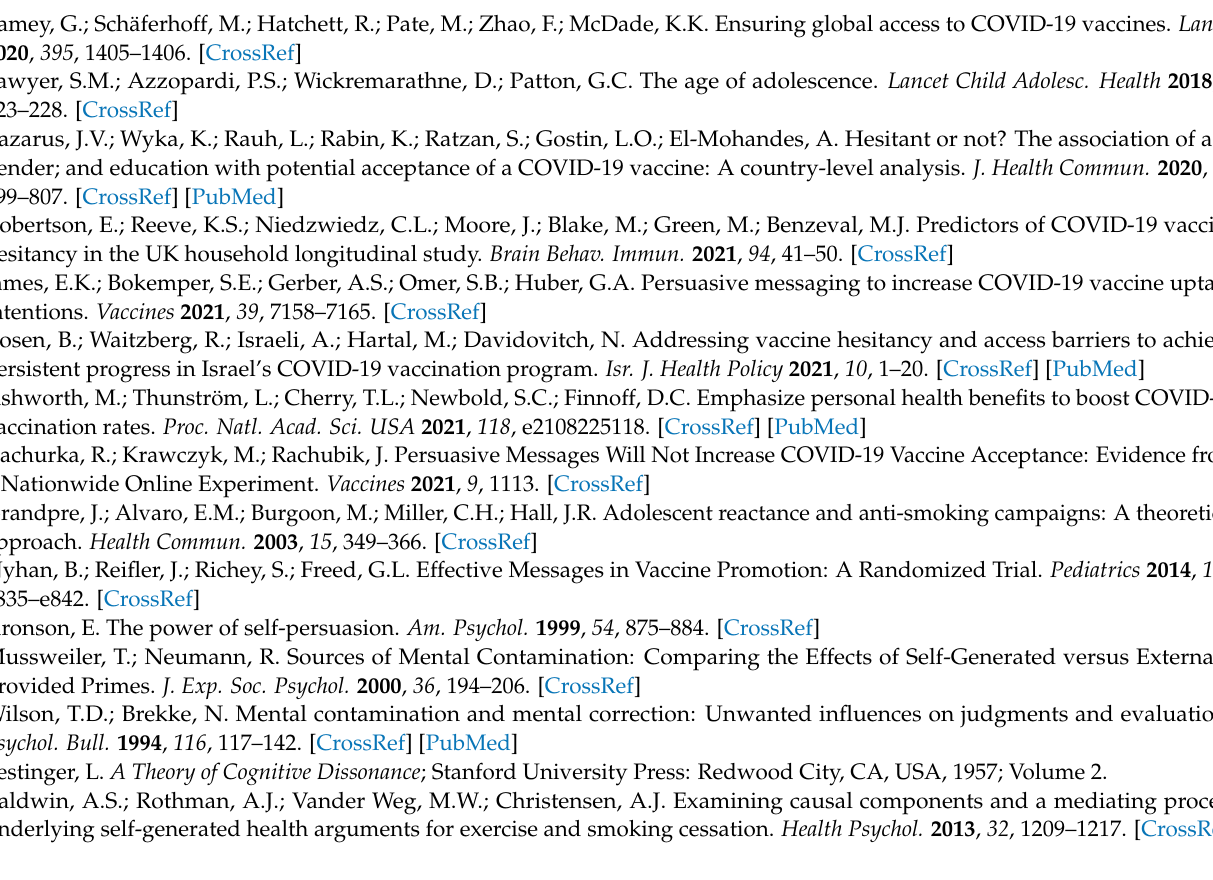
Table S3: Means, standard deviations and factor loading for all items in Study 2; Table S4: Descriptive statistics for each group in Study 2; Table S5: Direct effects, indirect effects and total effects in Study 1 and Study